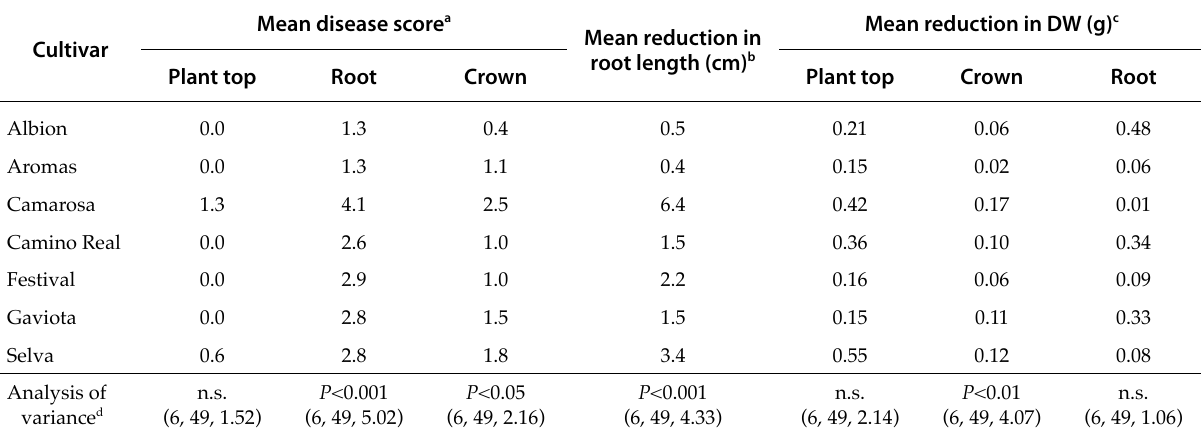
Table 6. Response of strawberry cultivars to Macrophomina phaseolina (WUF-ST-MP3) assessed as disease scores (0‒5 scale) for plant top, root, and crown, reduction in root length (cm), reduction in dry weight (DW) (g) of plant top, root and crown for seven strawberry cultivars under controlled enrironment conditions, and analysis of variance for each parameter as- sessed in relation to cultivar.